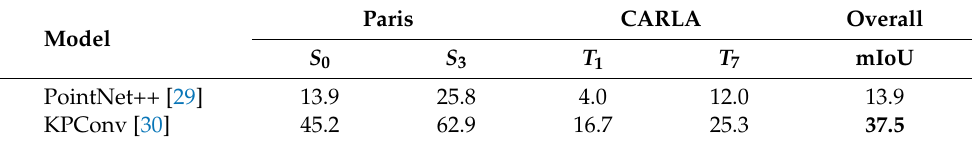
Table 2. Results in semantic segmentation task using PointNet++ and KPConv architectures on our dataset, Paris-CARLA-3D. Results are mIoU in %. For S 0 and S 3 , training set is S 1 , S 2 . For T 1 and T 7 , training set is T 2 , T 3 , T 4 and T 5 . Overall mIoU is the mean IoU on the whole test sets (real and synthetic).